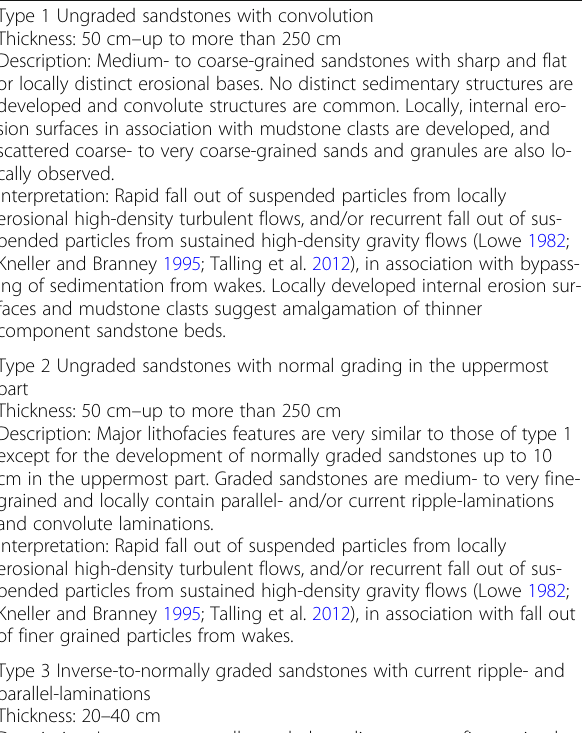
Table 1 Lithofacies types and their inferred depositional processes. The outcrop features of each lithofacies type are shown in Fig. S6.